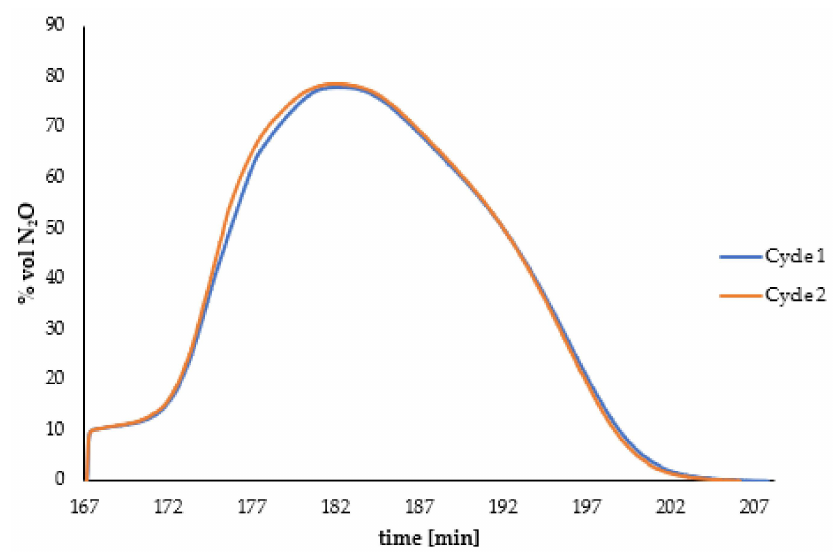
Figure 5. Desorption curve obtained in two consecutive cycles performed at 10% vol of N 2